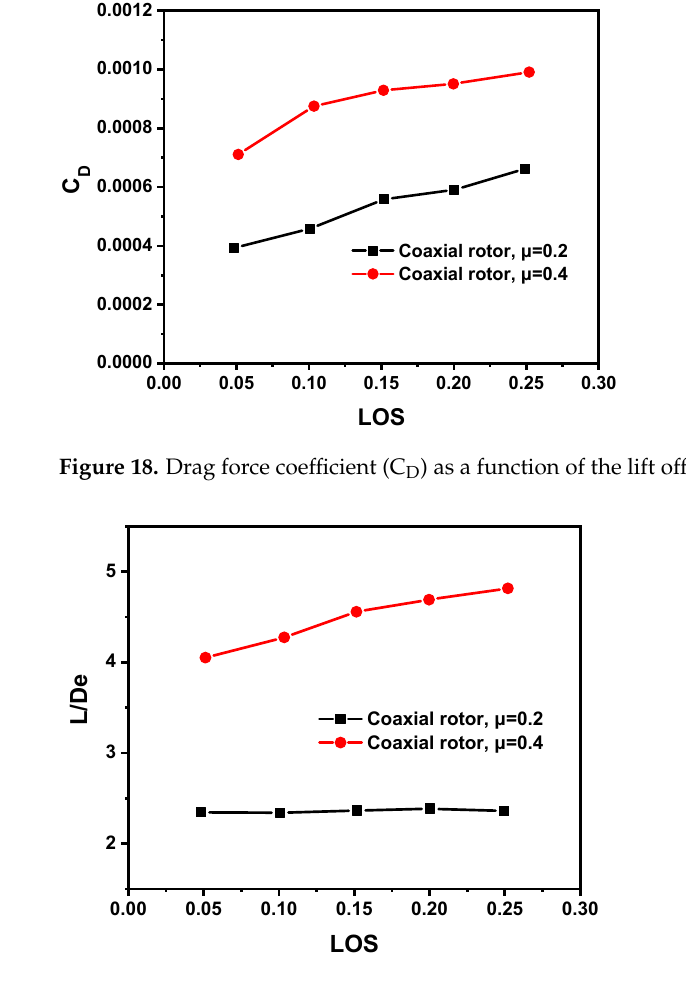
Figure 17. Power coefficient (C P ) as a function of the lift offset (LOS).